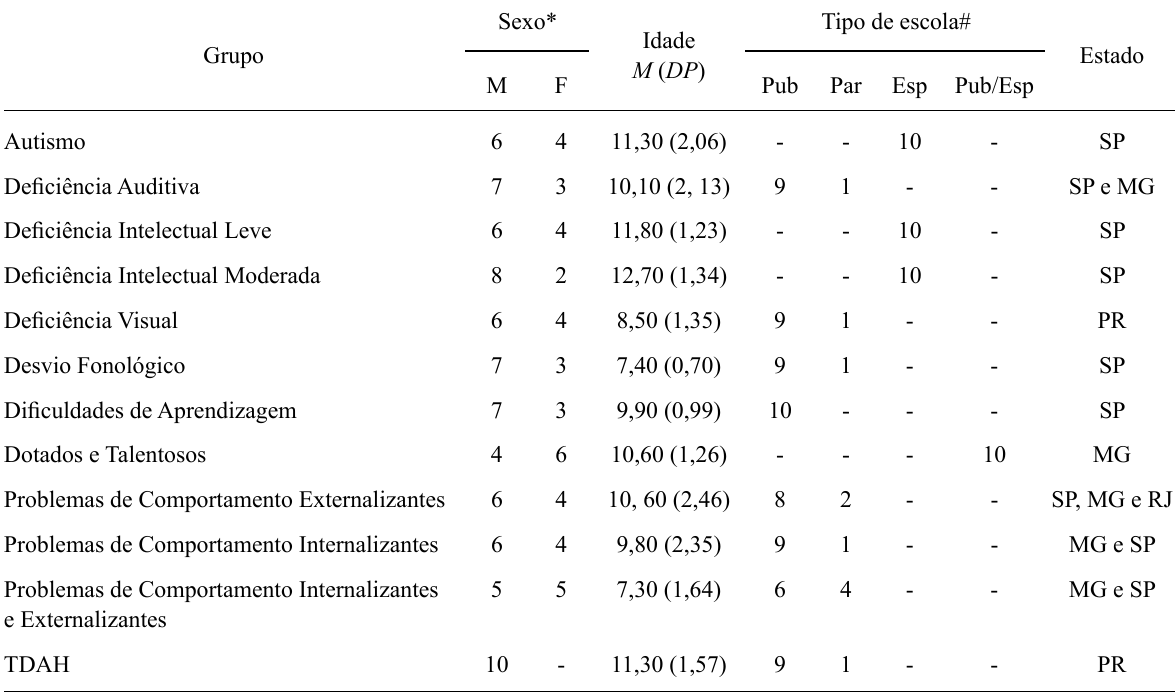
Características Sociodemográ fi cas dos Diferentes Grupos de